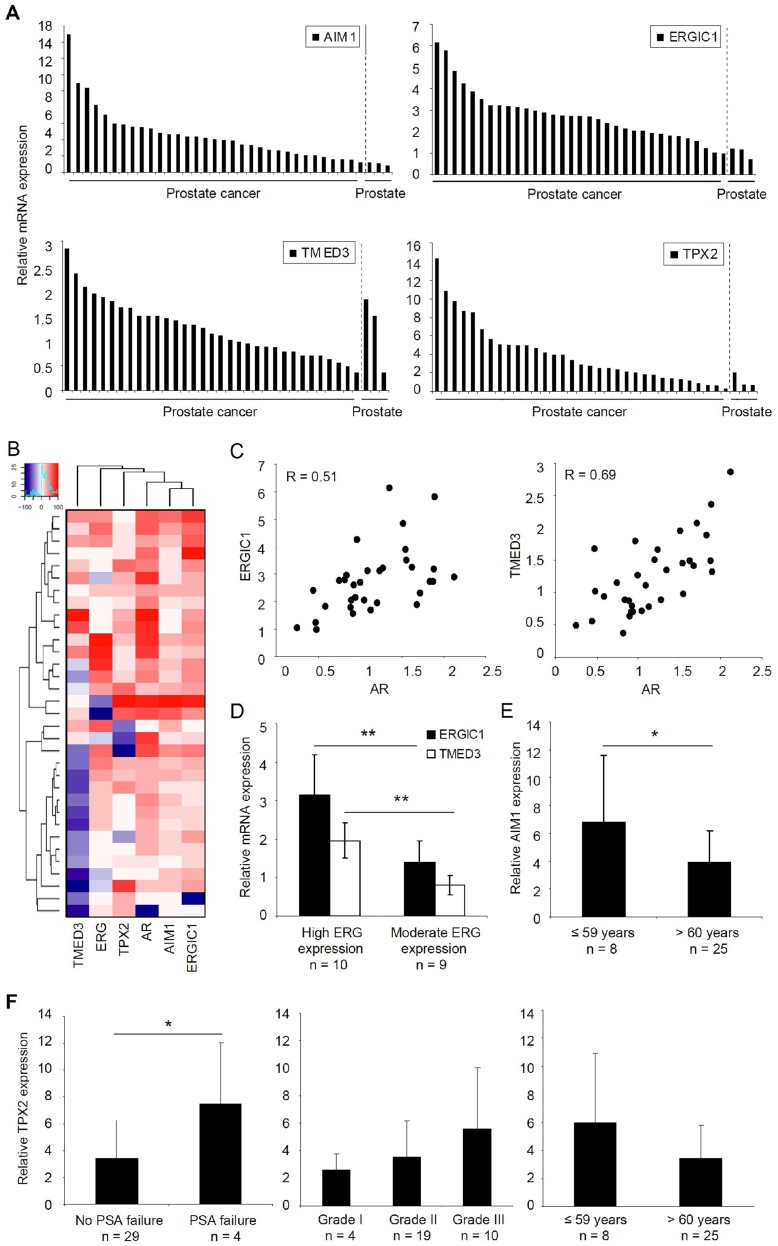
Validation of AIM1, ERGIC1, TMED3 and TPX2 expression in clinical prostate tissue samples. 
A. The mRNA expression of target genes in 33 primary prostate cancer and 3 non-malignant prostate tissue samples. The mean expression the non-malignant samples has been set as 1. B. Heatmap visualization of the gene-wise scaled relative mRNA expression values for AIM1, ERGIC1, TMED3, TPX2, ERG, and AR in 33 primary prostate cancer tissues. The heatmap is drawn based on unsupervised hierarchical clustering of the expression values. Relative mean expression level in normal control samples was set as 0. C. Co-expression patterns between ERGIC1 and AR mRNA, as well as TMED3 and AR mRNA in 33 primary prostate cancer samples. D. Association of ERGIC1 and TMED3 mRNA expression with ERG mRNA expression in the ERG positive primary prostate tumors (n = 19). E. Relative mRNA expression of AIM1 in primary prostate cancer samples in comparison to patient age. F. Relative mRNA expression of TPX2 in primary prostate cancer samples in comparison to occurrence of PSA failure, WHO tumor grade and patient age.